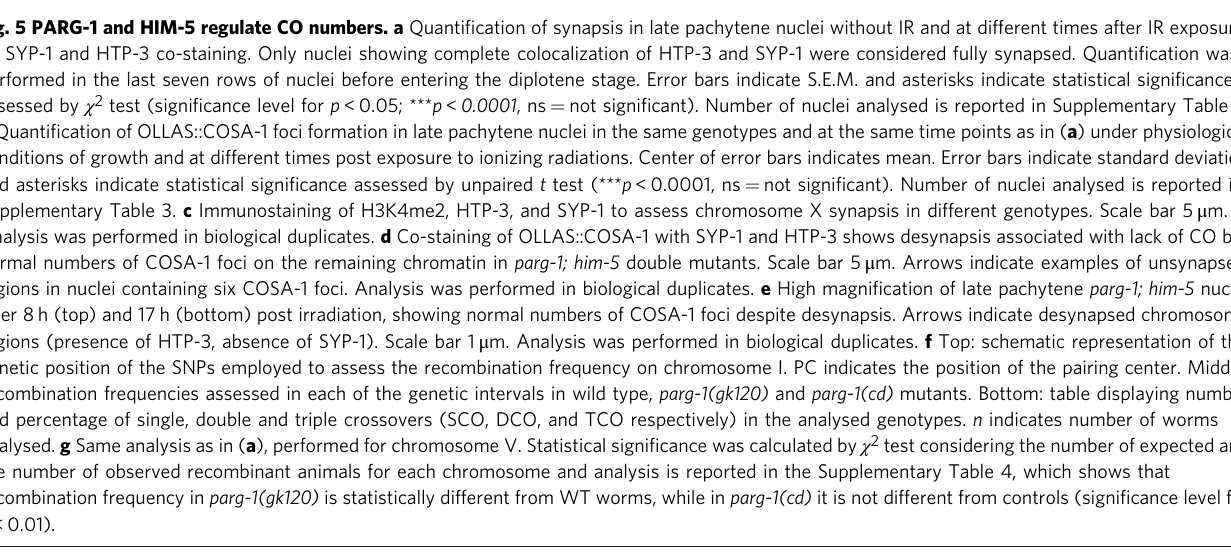
Fig. 5 PARG-1 and HIM-5 regulate CO numbers. a Quanti fi cation of synapsis in late pachytene nuclei without IR and at different times after IR exposure, by SYP-1 and HTP-3 co-staining. Only nuclei showing complete colocalization of HTP-3 and SYP-1 were considered fully synapsed. Quanti fi cation was performed in the last seven rows of nuclei before entering the diplotene stage. Error bars indicate S.E.M. and asterisks indicate statistical signi fi cance assessed by χ 2 test (signi fi cance level for p < 0.05; *** p < 0.0001 , ns = not signi fi cant). Number of nuclei analysed is reported in Supplementary Table 3. b Quanti fi cation of OLLAS::COSA-1 foci formation in late pachytene nuclei in the same genotypes and at the same time points as in ( a ) under physiological conditions of growth and at different times post exposure to ionizing radiations. Center of error bars indicates mean. Error bars indicate standard deviation and asterisks indicate statistical signi fi cance assessed by unpaired t test (*** p < 0.0001, ns = not signi fi cant). Number of nuclei analysed is reported in Supplementary Table 3. c Immunostaining of H3K4me2, HTP-3, and SYP-1 to assess chromosome X synapsis in different genotypes. Scale bar 5 μ m. Analysis was performed in biological duplicates. d Co-staining of OLLAS::COSA-1 with SYP-1 and HTP-3 shows desynapsis associated with lack of CO but normal numbers of COSA-1 foci on the remaining chromatin in parg-1; him-5 double mutants. Scale bar 5 μ m. Arrows indicate examples of unsynapsed regions in nuclei containing six COSA-1 foci. Analysis was performed in biological duplicates. e High magni fi cation of late pachytene parg-1; him-5 nuclei after 8 h (top) and 17 h (bottom) post irradiation, showing normal numbers of COSA-1 foci despite desynapsis. Arrows indicate desynapsed chromosome regions (presence of HTP-3, absence of SYP-1). Scale bar 1 μ m. Analysis was performed in biological duplicates. f Top: schematic representation of the genetic position of the SNPs employed to assess the recombination frequency on chromosome I. PC indicates the position of the pairing center. Middle: recombination frequencies assessed in each of the genetic intervals in wild type, parg-1(gk120) and parg-1(cd) mutants. Bottom: table displaying number and percentage of single, double and triple crossovers (SCO, DCO, and TCO respectively) in the analysed genotypes. n indicates number of worms analysed. g Same analysis as in ( a ), performed for chromosome V. Statistical signi fi cance was calculated by χ 2 test considering the number of expected and the number of observed recombinant animals for each chromosome and analysis is reported in the Supplementary Table 4, which shows